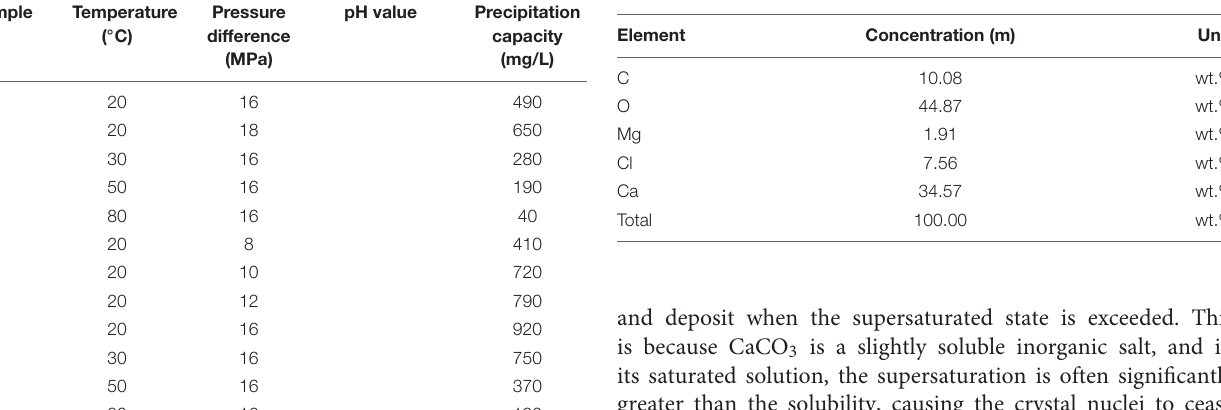
TABLE 3 | Elemental composition of the precipitates generated from CO 2 –formation brine interaction.